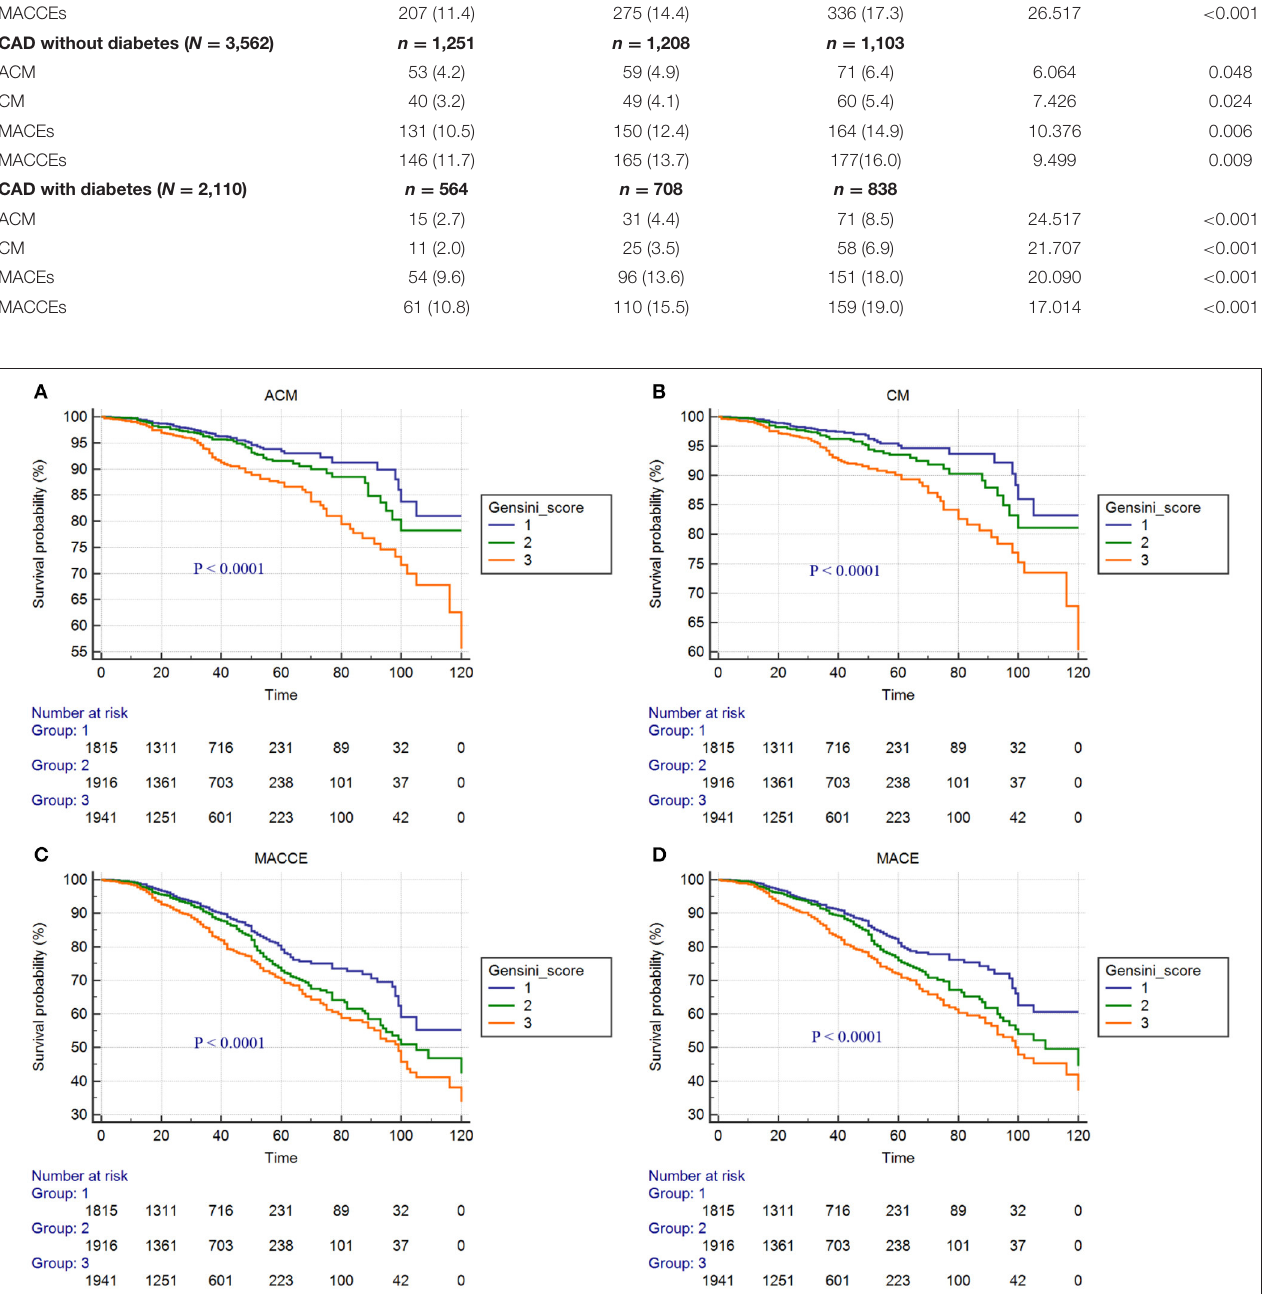
FIGURE 2 | Cumulative Kaplan-Meier estimates of the time to the first adjudicated occurrence of primary endpoints and secondary endpoints: (A) ACM; (B) CM; (C) MACCEs; (D) MACEs. (In the total population).